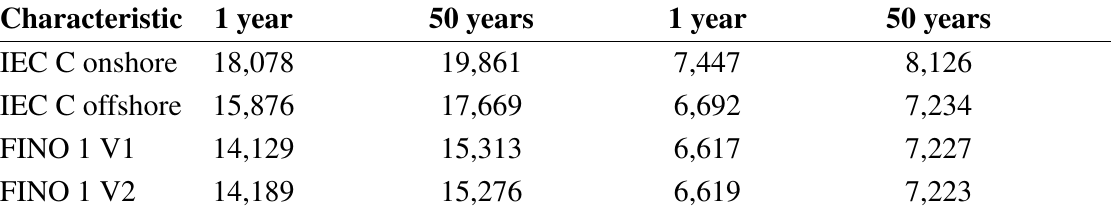
Table 3. Characteristic extreme loads calculated by means of the ACER